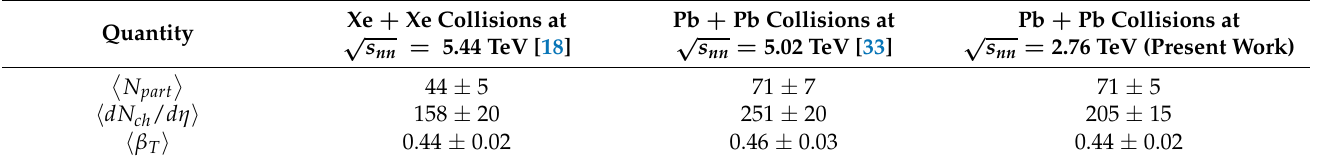
(cid:10) (cid:11) N part , (cid:104) dN ch / d η (cid:105) , and (cid:104) β t (cid:105) , estimated in Pb + Pb √ s nn = 5.02 TeV